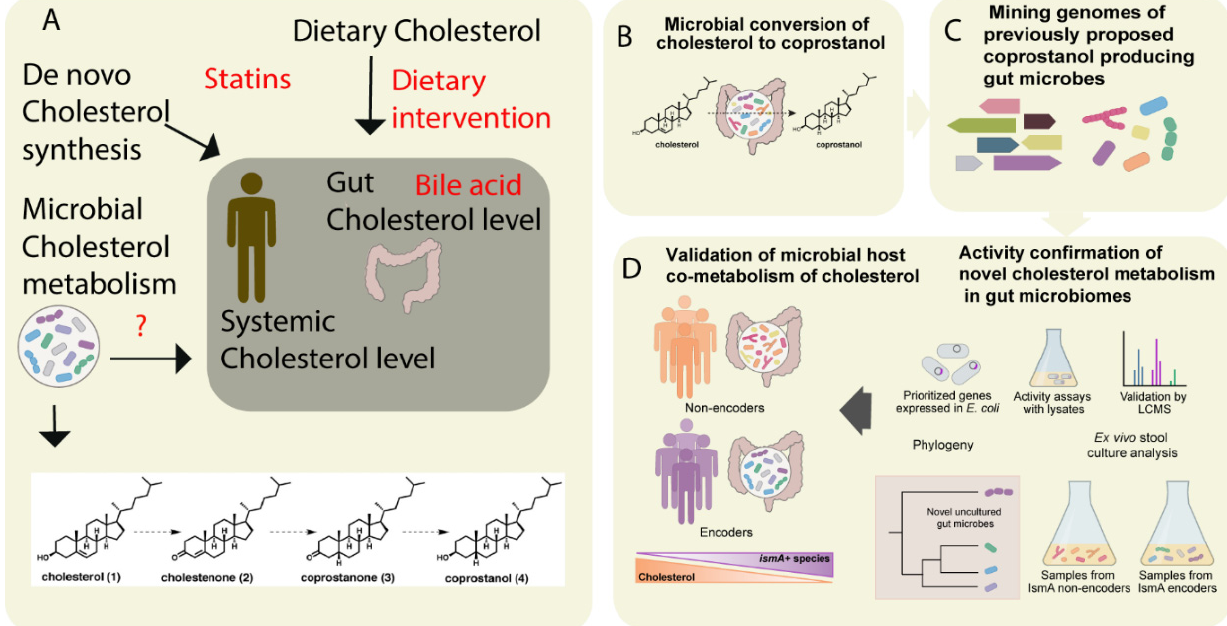
Figure 2. The metabolism of cholesterol by gut microbes influences both intestinal and circulating cholesterol concentrations. ( A ) The cholesterol level in the blood can be influenced either by de novo cholesterol synthesized in the liver or it may be derived from exogenous sources such as the diet. The endogenous cholesterol level may be also influenced by drugs such as statins, or via altered bile acid metabolism. In addition, gut microbial metabolism of cholesterol may also serve as check point for the maintenance of cholesterol homeostasis ( B ). As shown in panel A , the authors proposed a pathway for microbial conversion of cholesterol (1) to coprostanol (4) in the microbiota involves the intermediates cholestenone (2) and coprostanone (3). ( C ) By using genome mining, Kenny et al. identified and characterized microbial enzymes linked with cholesterol metabolism. Later, integrating the functional metagenomics and metabolomics data, they predicted as well as validated a group of microbes and their microbial activities (microbial cholesterol dehydrogenases) which mediated the metabolism of cholesterol in the gut ( D ). Figure adapted from [52] with permission under CC BY 4.0 license.